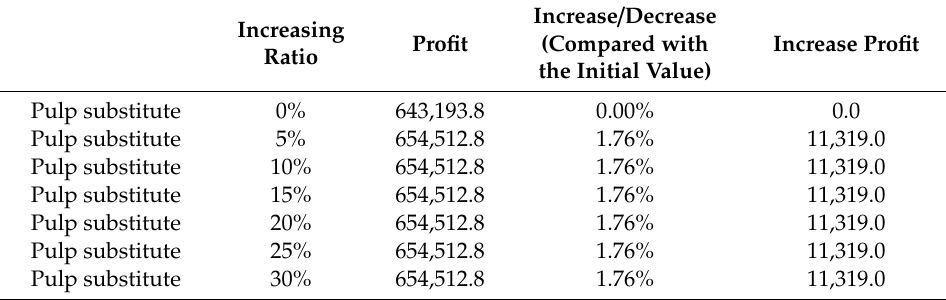
Table 6. Sensitivity analysis on the available capacity of pulp substitute.